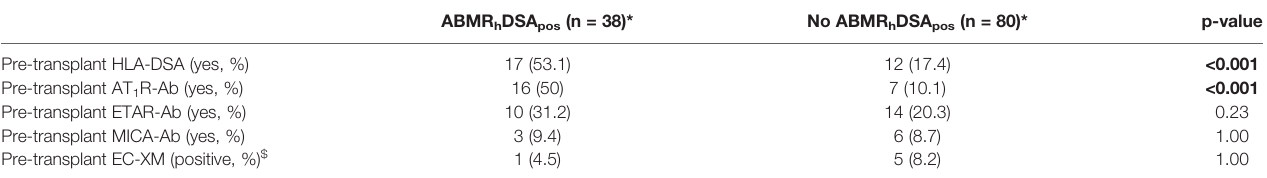
TABLE 3B | Pre-transplant HLA and non-HLA antibodies: comparison between ABMR h DSA pos and non-ABMR h DSA pos cases (normal histology, IFTA and ABMR h DSA neg